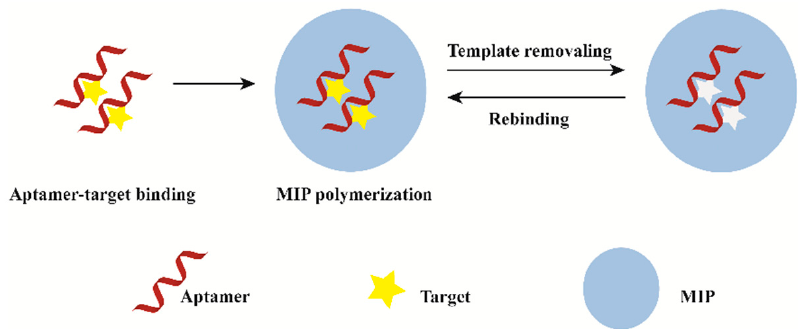
Figure 1. General description of the synthesis process of MIP–aptamer.